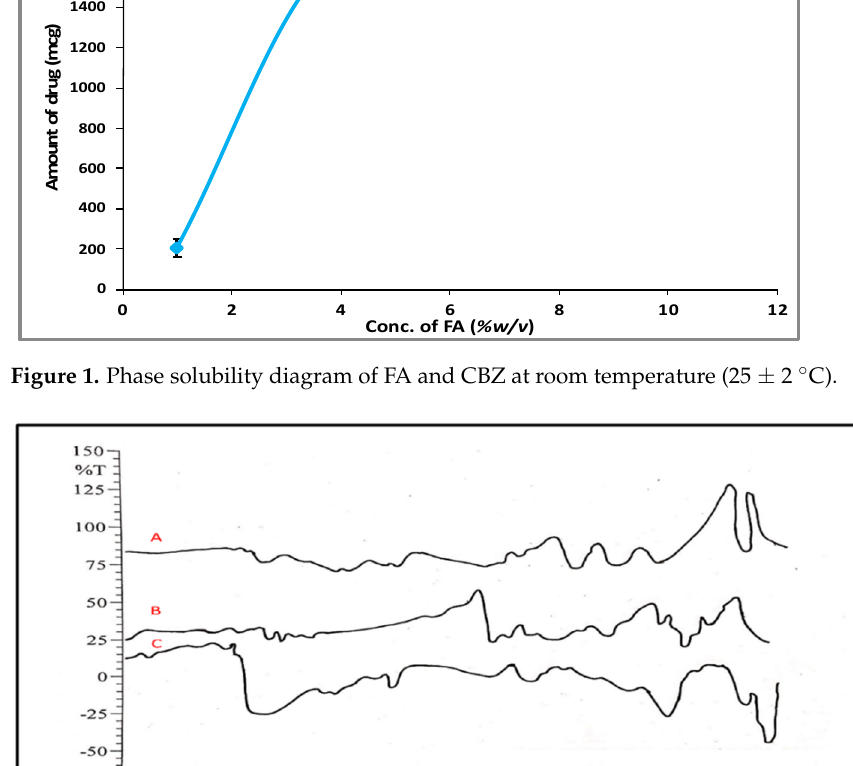
Figure 2. FTIR overlay spectra of FA (A), CBZ (B), and CBZ-FA complex (C).